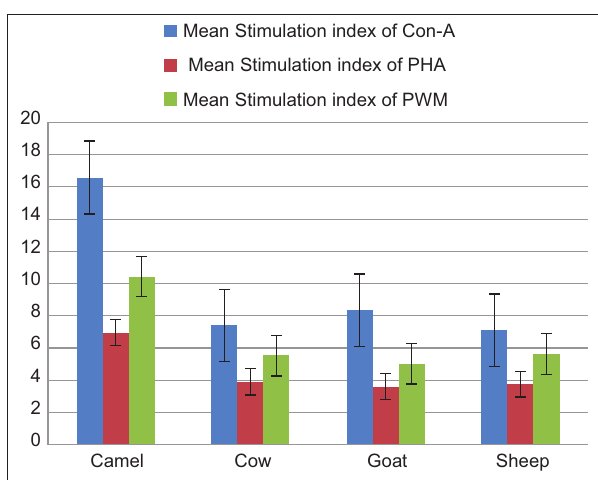
Figure-7: Comparison stimulation indices of peripheral blood mononuclear leukocyte of camels, goats, sheep, and cows stimulated with concanavalin A, phytohemagglutinin and pokeweed